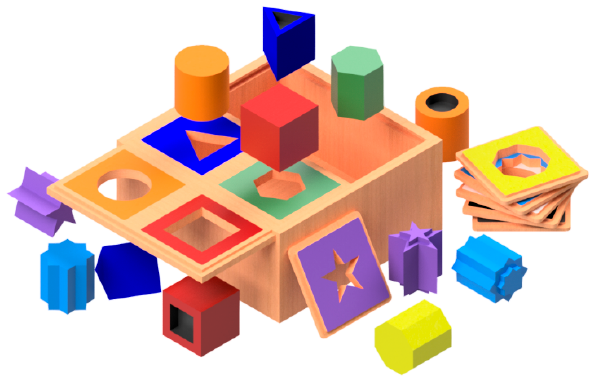
Figure 2. Configurable toy sorting box with according brick variants.